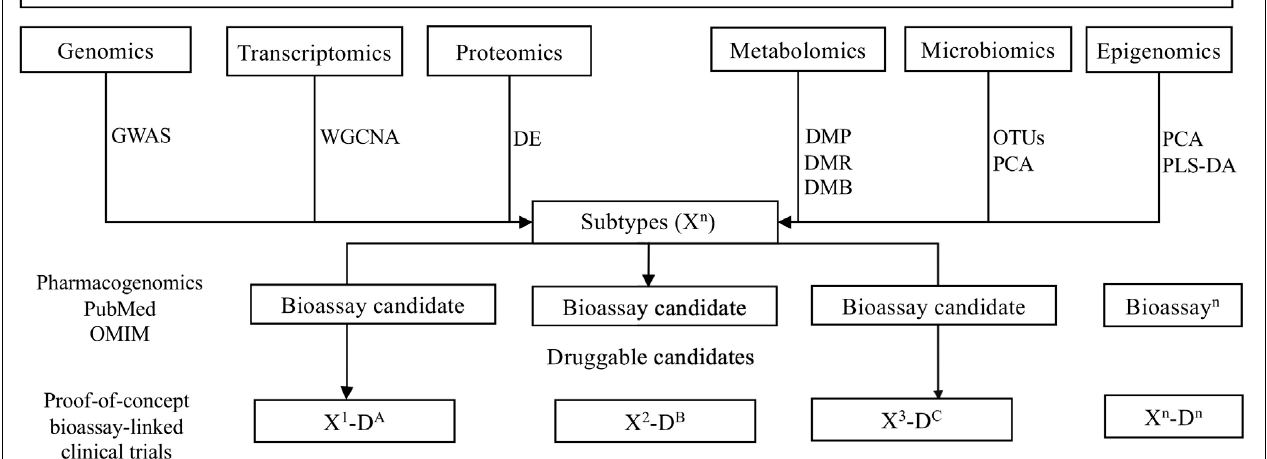
Frontiers in Aging Neuroscience |